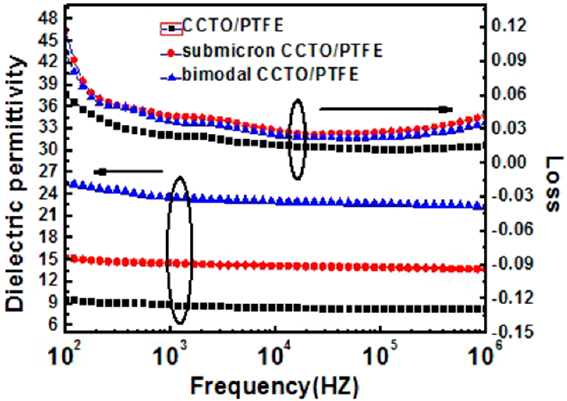
Figure 7. Frequency dependence of the dielectric properties of the composites with various CCTO particles: ( a ) the relative permittivity and ( b ) dielectric loss.